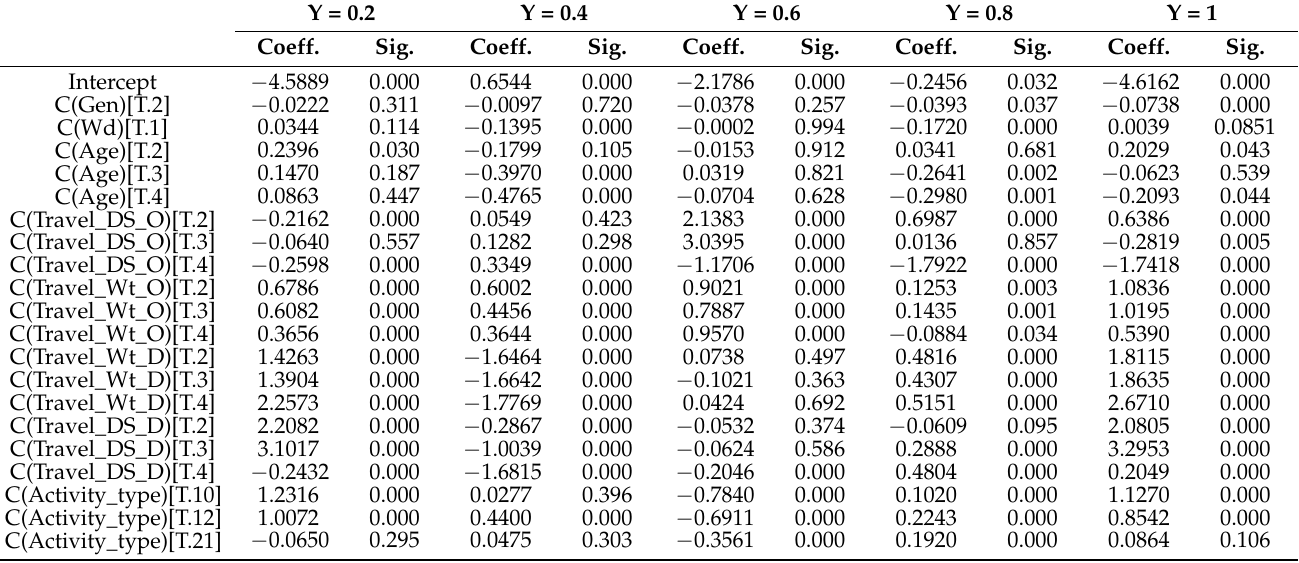
Table 11. Simulation results of multinomial logit model (May